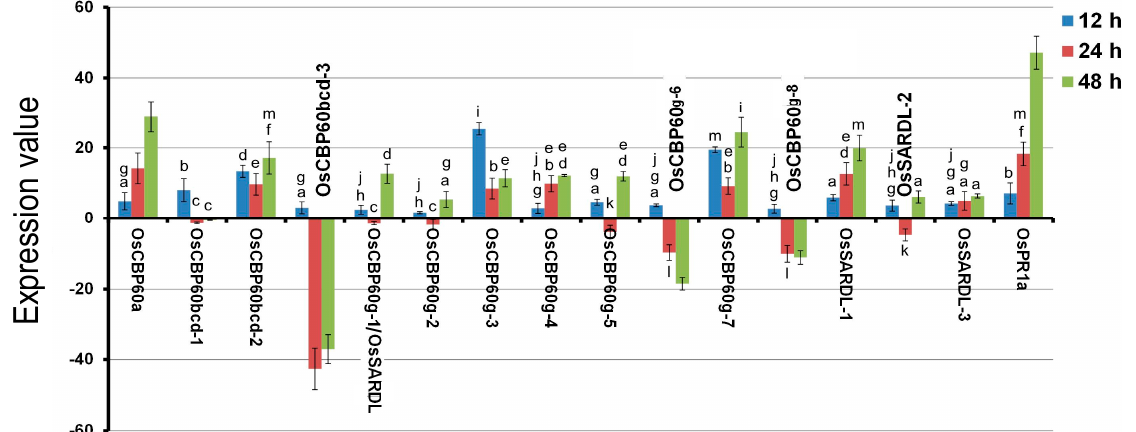
Figure 7. Transcriptional response of OsCBP60 genes in rice seedlings infected with X. oryzae pv. oryzae . Rice seedlings were infected with X. oryzae and transcript levels were analyzed by qRT-PCR at 12, 24 and 48 h post infection. Relative transcript abundance (expression value) is expressed as fold-change relative to the mock treatment. OsPR1a expression served as a positive control. Results are representative of three independent experiments. Error bars represent standard error (SE) of mean for three replicates. Superscripts with the same letter are not significantly different ( p < 0.05) by one-way ANOVA-protected LSD